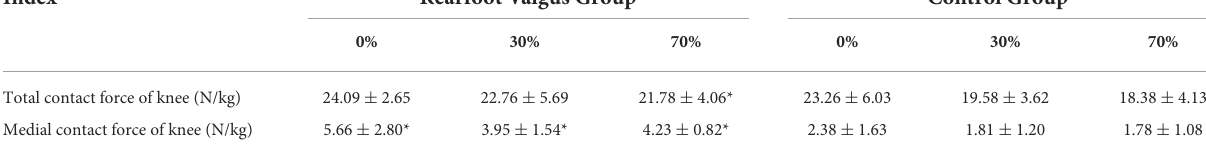
TABLE 4 Peak knee joint reaction force.